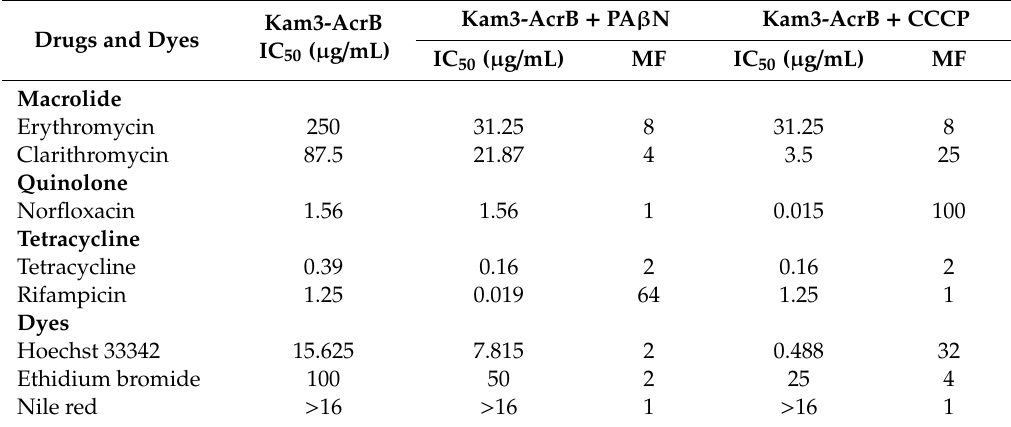
Table 1. The IC 50 of Kam3-AcrB against drugs and dyes in the presence of modulator PA β N and CCCP. Kam3-AcrB + PA β N Kam3-AcrB + CCCP Kam3-AcrB Drugs and Dyes IC 50 ( µ g / mL) IC 50 ( µ g / mL) MF IC 50 ( µ g / mL) MF Macrolide Erythromycin 250 31.25 8 31.25 8 Clarithromycin 87.5 21.87 4 3.5